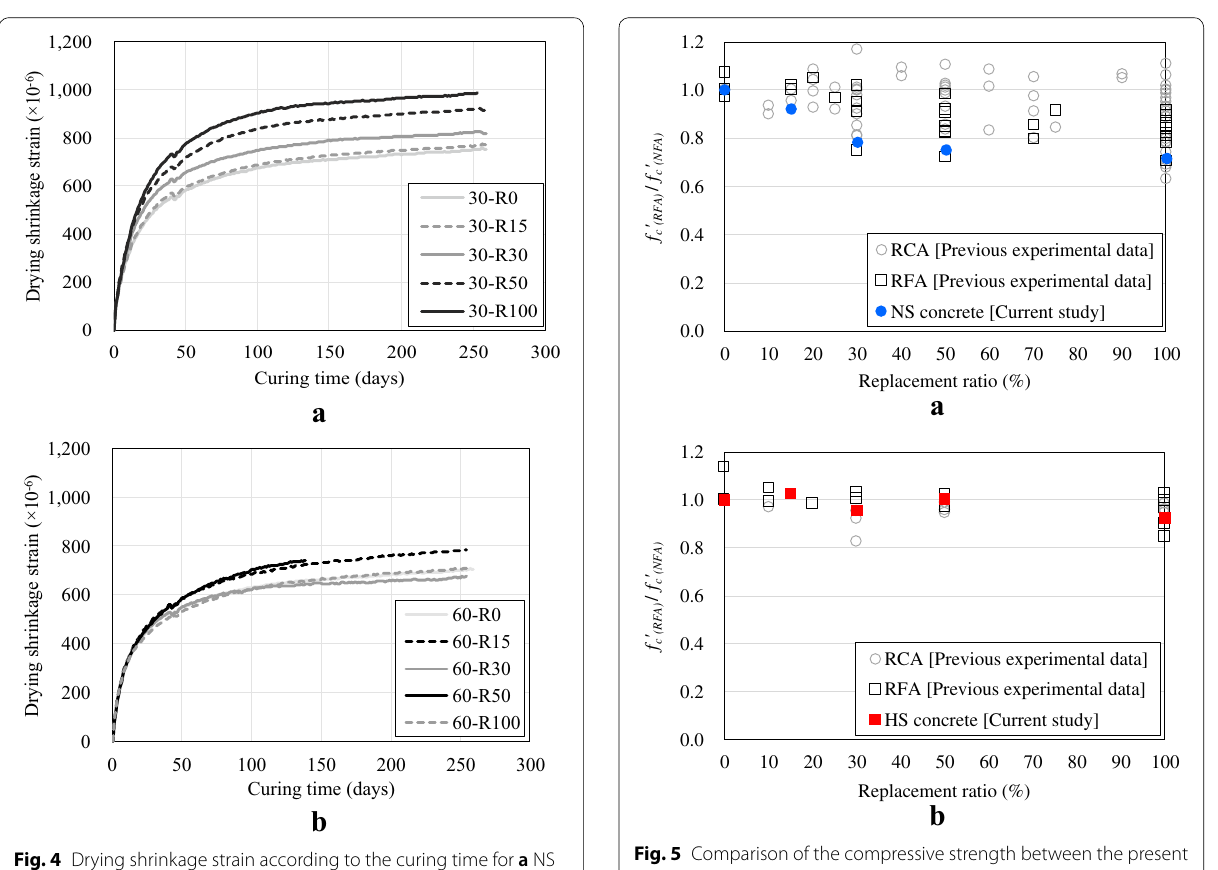
Fig. 4 Drying shrinkage strain according to the curing time for a NS concrete, and b HS concrete.